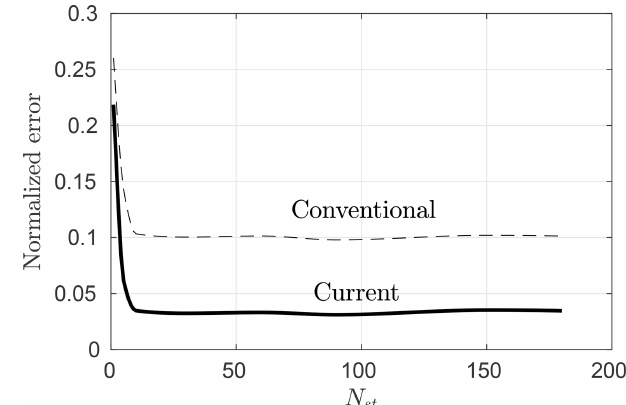
Figure 5. Normalized error as a function of the number of stream- tubes shown for both conventional and current DMST models, for a three-bladed turbine at Re D = 2 . 85 × 10 6